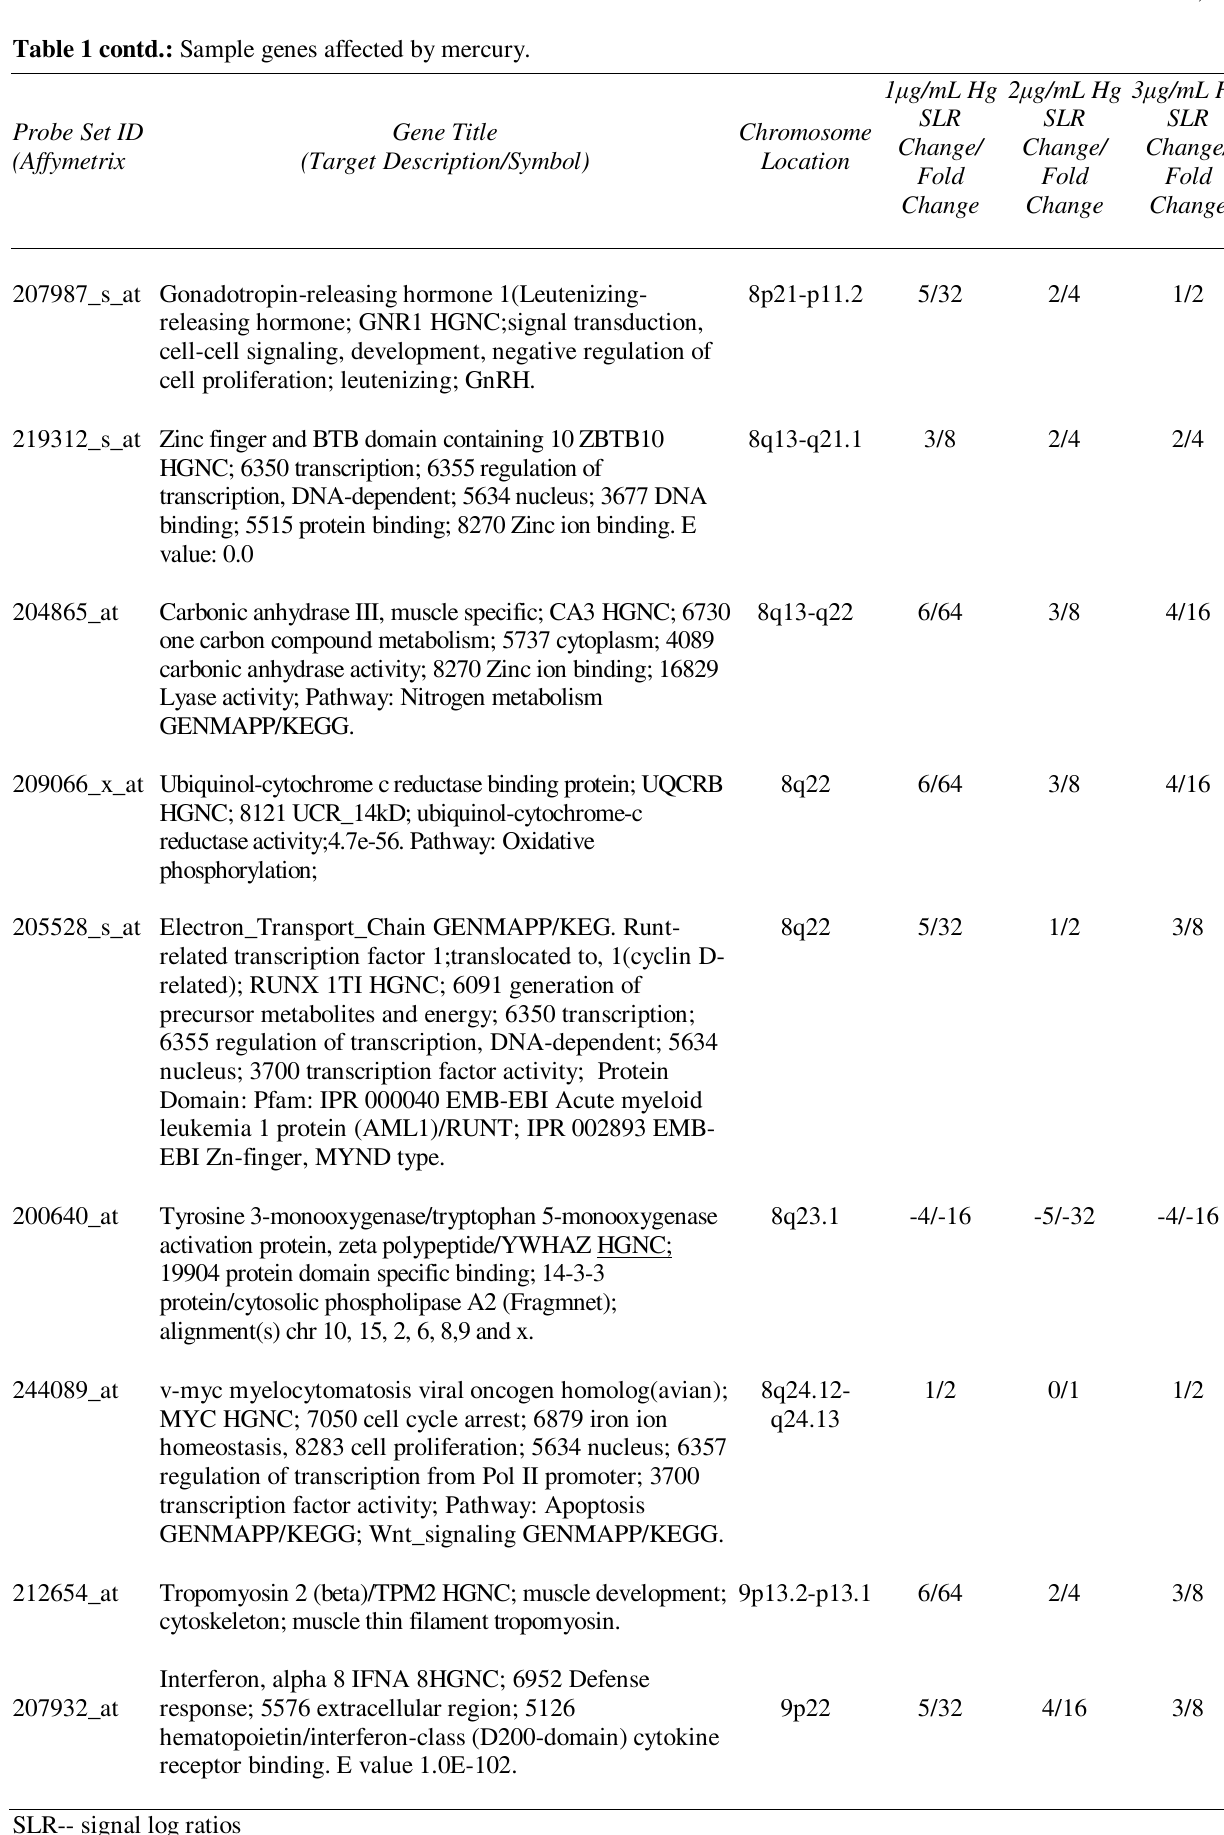
SLR-- signal log ratios